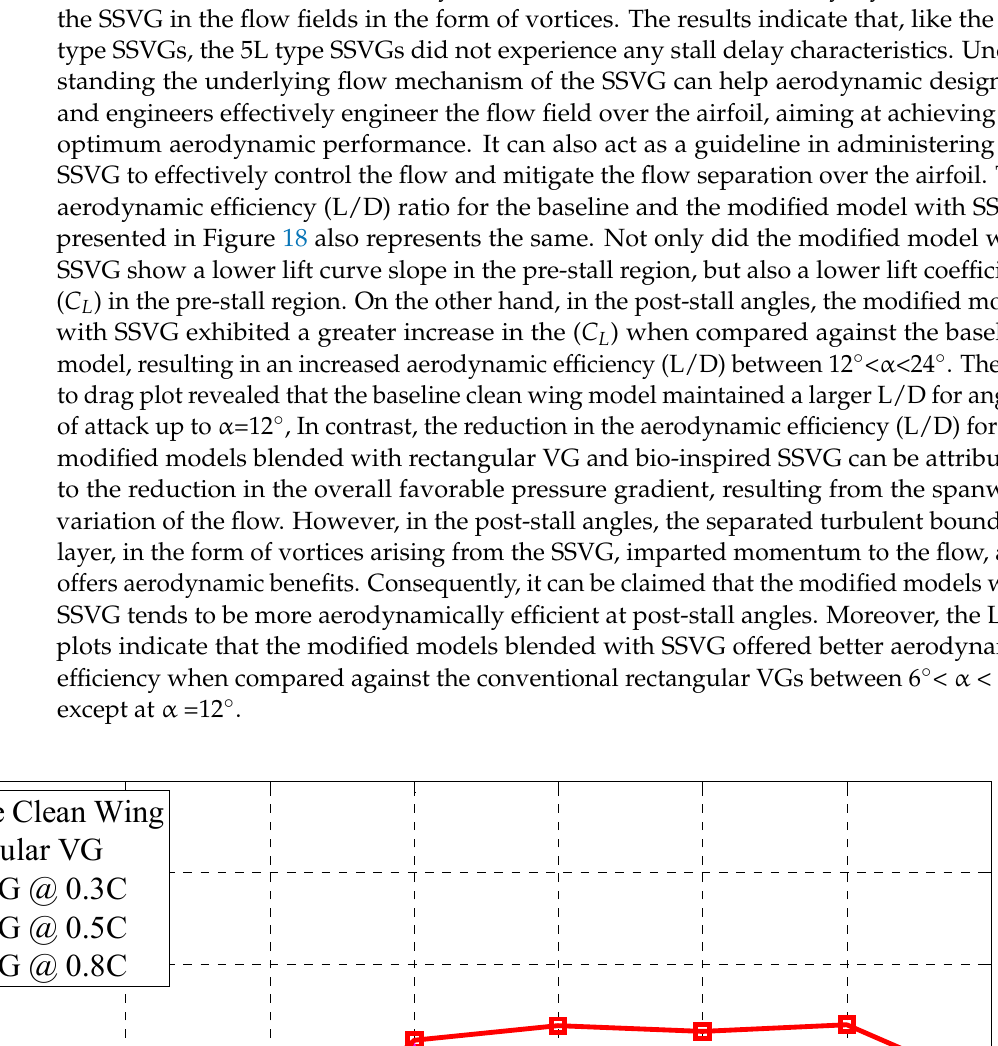
A comparison of the aerodynamic forces like the coefficient of lift ( C L ) and coefficient of drag ( C D ) for the baseline clean wing configuration, modified model blended with rectangular VG, and modified model blended with three different sets of SSVG at various chordwise locations (x/C) is shown in Figures 19 and 20,